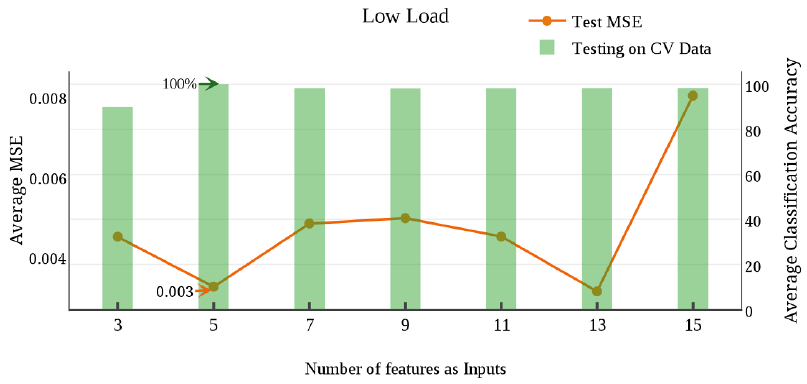
Figure 11. Variation of average classification and MSE with a number of features as inputs in Low Load.